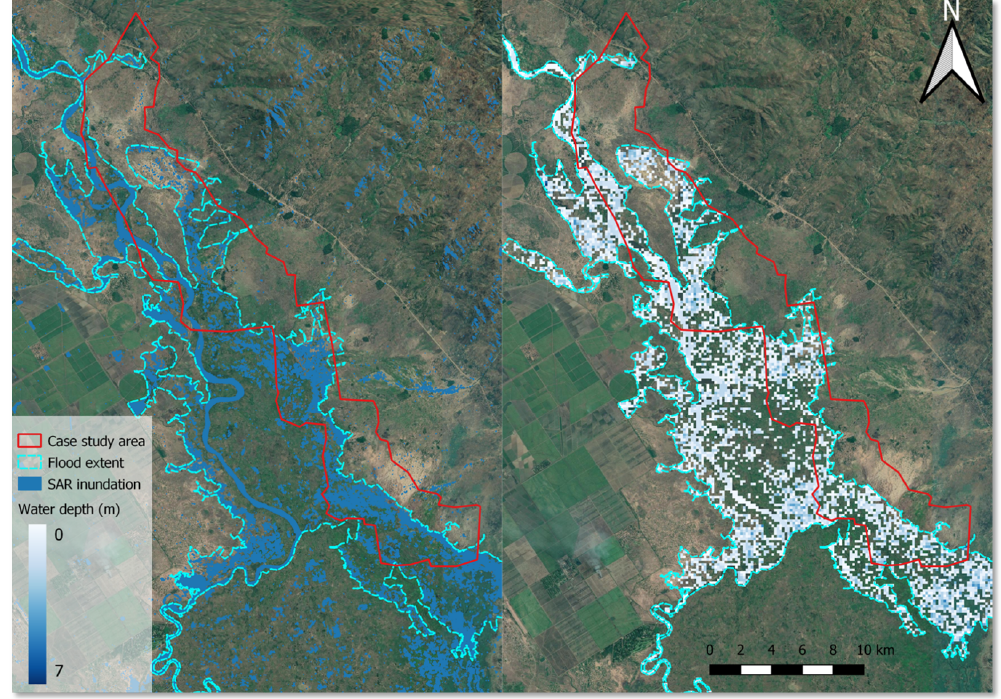
Figure 12. The flood extent for the case study area extracted from SAR imagery (left) and the derived water depth map using surface water interpolation based on the SRTM DEM (right). The inundation maps are shown on © Google Satellite